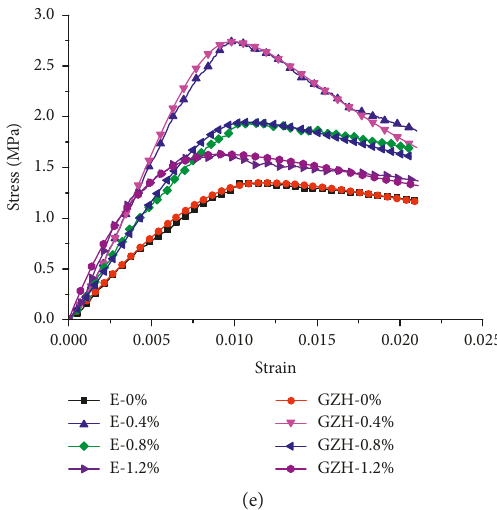
Figure 5: Fitting results of the curve of BF-CRM based on the modified GZH model: (a) A group; (b) B group; (c) C group; (d) D group; (e) E group.